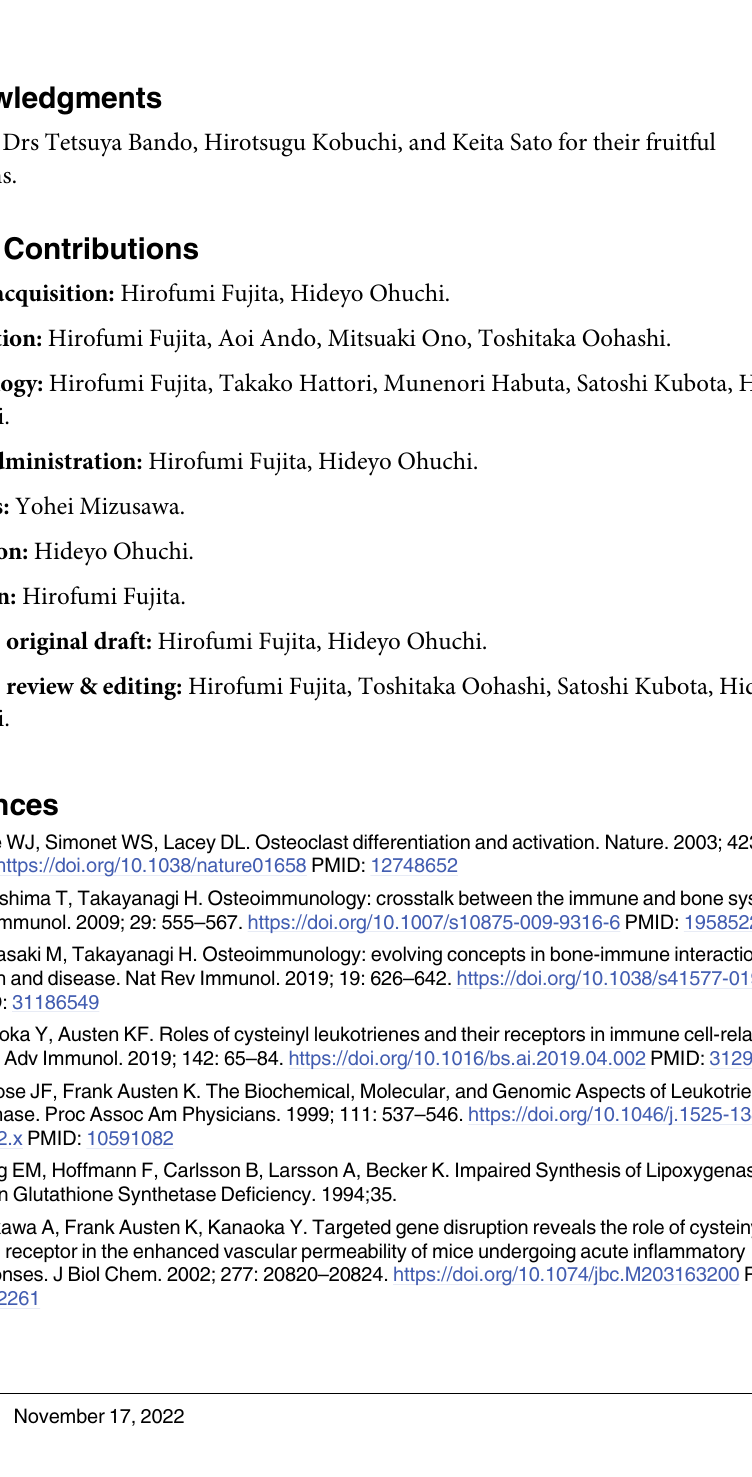
S1 Raw images. Raw agarose gel images of Fig 4 and S4